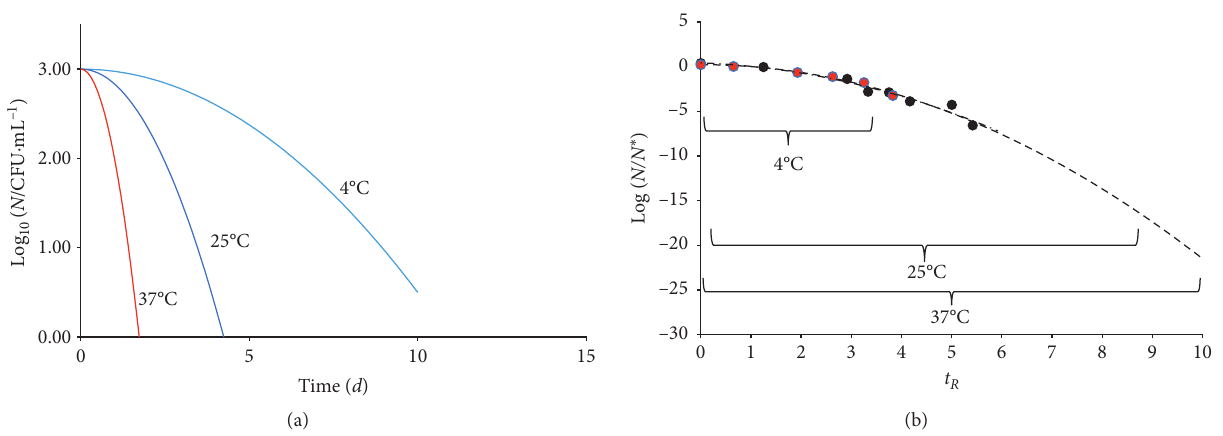
Figure 5: Decay trends of E. coli in lager beer at different temperatures. (a) The curves correspond to equation (3) and closely describe the trend of the experimental data reported in [15]. (b) The same data gathered in a single master plot of reduced variables, according to equation (8), matched with those relevant to E. coli (full circles) reported in Figure 3.